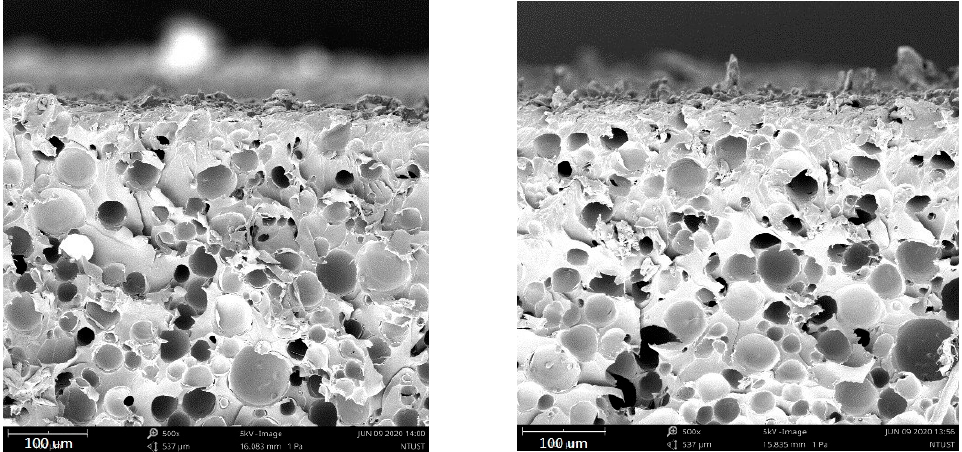
Figure 11. Cross-section SEM photo of pad.